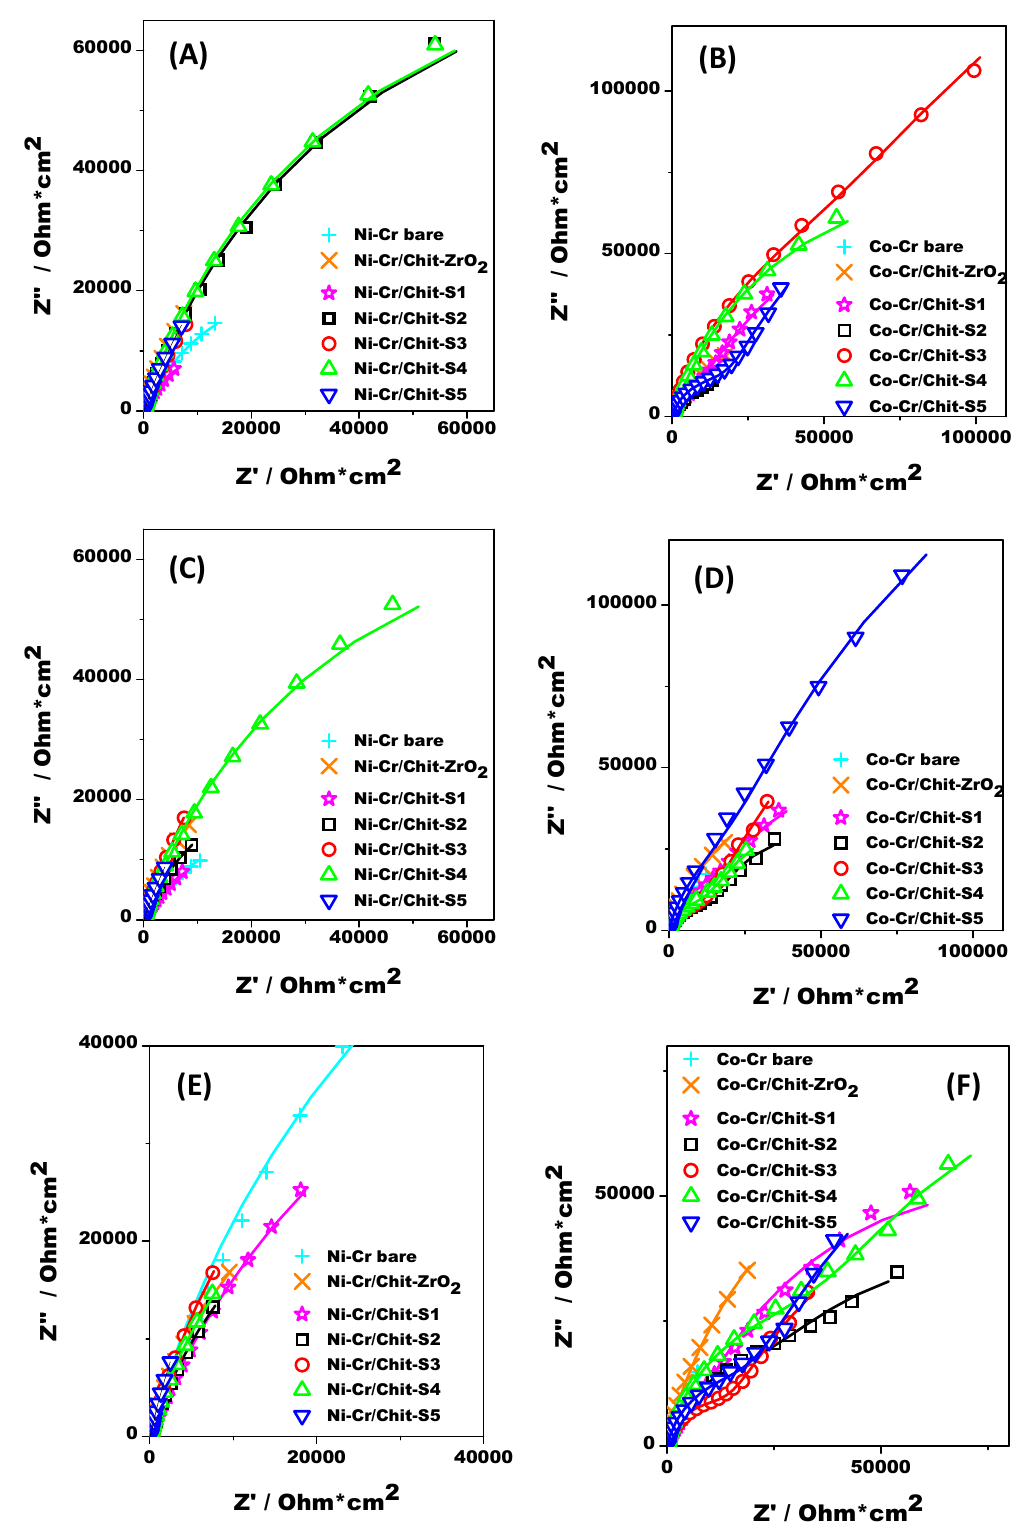
Figure 5. Nyquist impedance diagram for Ni-Cr ( A , C , E ) and Co-Cr ( B , D , F ) bare electrodes ( + , cyan) and covered with ZrO 2 (X, orange), S1 ( ∗ , magenta), S2 ( (cid:3) , black), S3 ( , red), S4 ( (cid:52) , green), S5 ( (cid:53) , blue) in chitosan membrane, recorded at the open circuit potential in artificial saliva of pH 4.3 ( A , B ), pH 5 ( C , D ), pH 6 ( E , F ) and the corresponding simulated data (solid line).